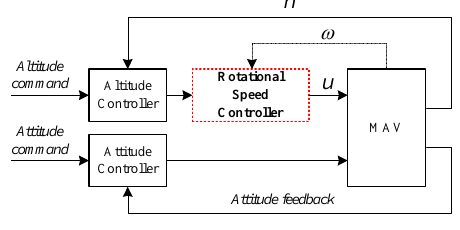
Figure 10. The control scheme.